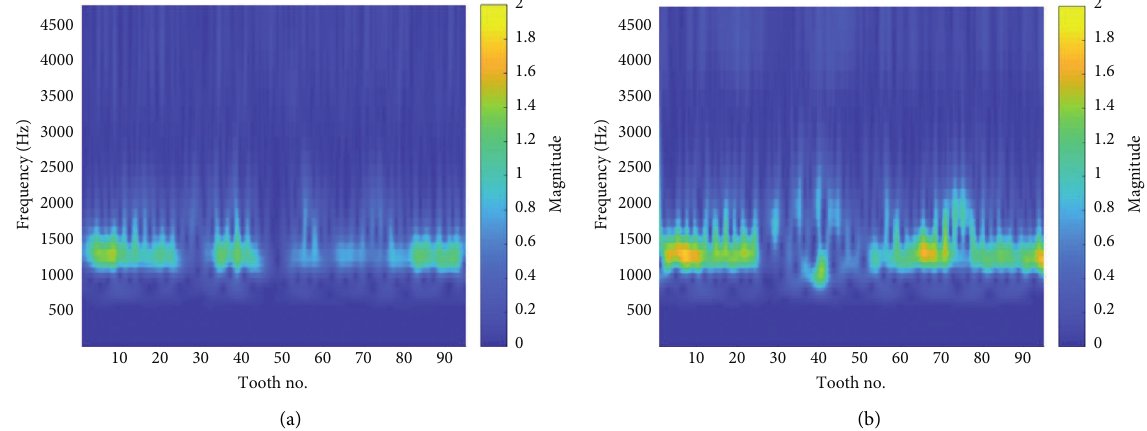
Figure 9: Wavelet analysis: (a) 500 hours and (b) 600 hours of